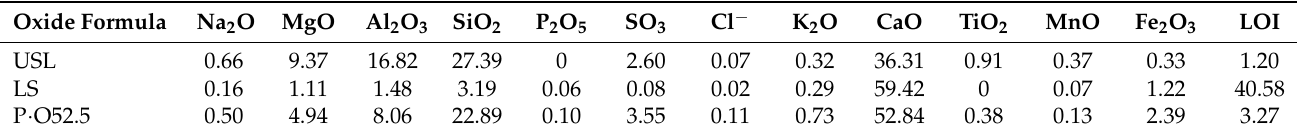
Table 1. Chemical composition of the binders (wt.%).